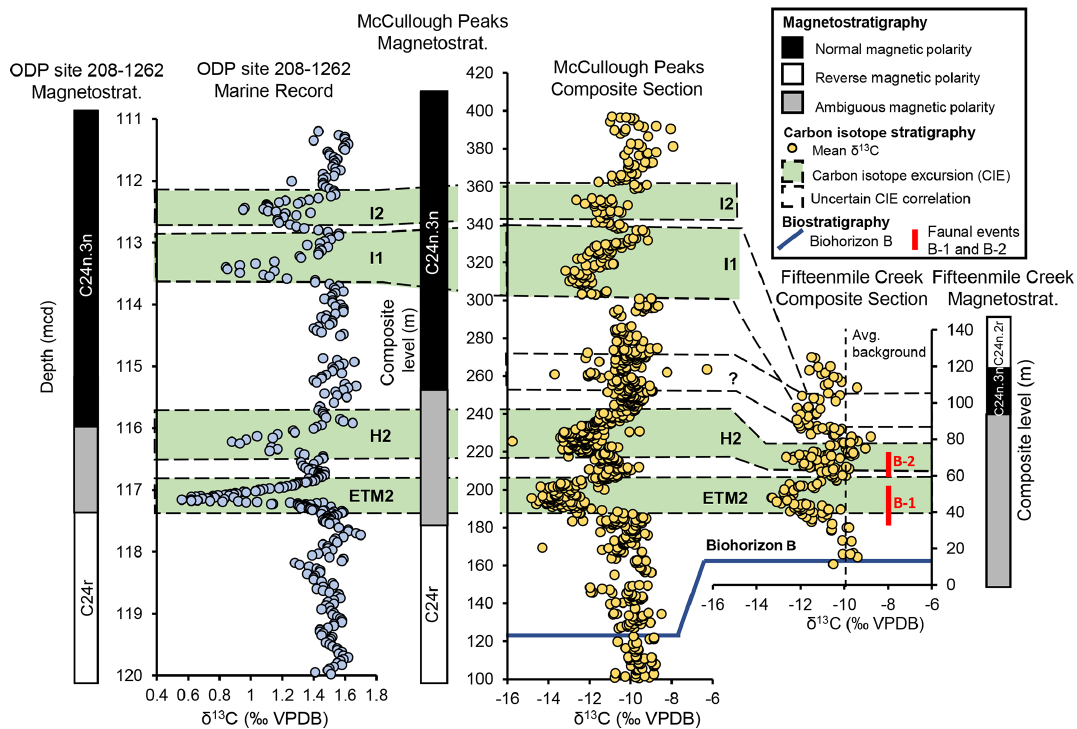
Figure 6. Correlation between ODP site 208-1262 (from Zachos et al., 2010), McCullough Peaks (from Abels et al., 2016), and Fifteenmile Creek (this study). All points represent mean δ 13 C values from a stratigraphic level. McCullough Peaks and Fifteenmile Creek records are shown at the same vertical scale. Two alternative correlations for the 85–104m Fifteenmile Creek composite level interval are shown. The blue line shows the approximate level of Biohorizon B in both terrestrial locations, and red bars show the levels associated with faunal events B-1 and B-2 in Fifteenmile Creek. McCullough Peaks magnetostratigraphy from Clyde et al. (2007), Abels et al. (2012), and D’Ambrosia et al. (2017). Fifteenmile Creek magnetostratigraphy from Clyde et al. (2007) (measured at Elk Creek Rim) and Tauxe et al. (1994).